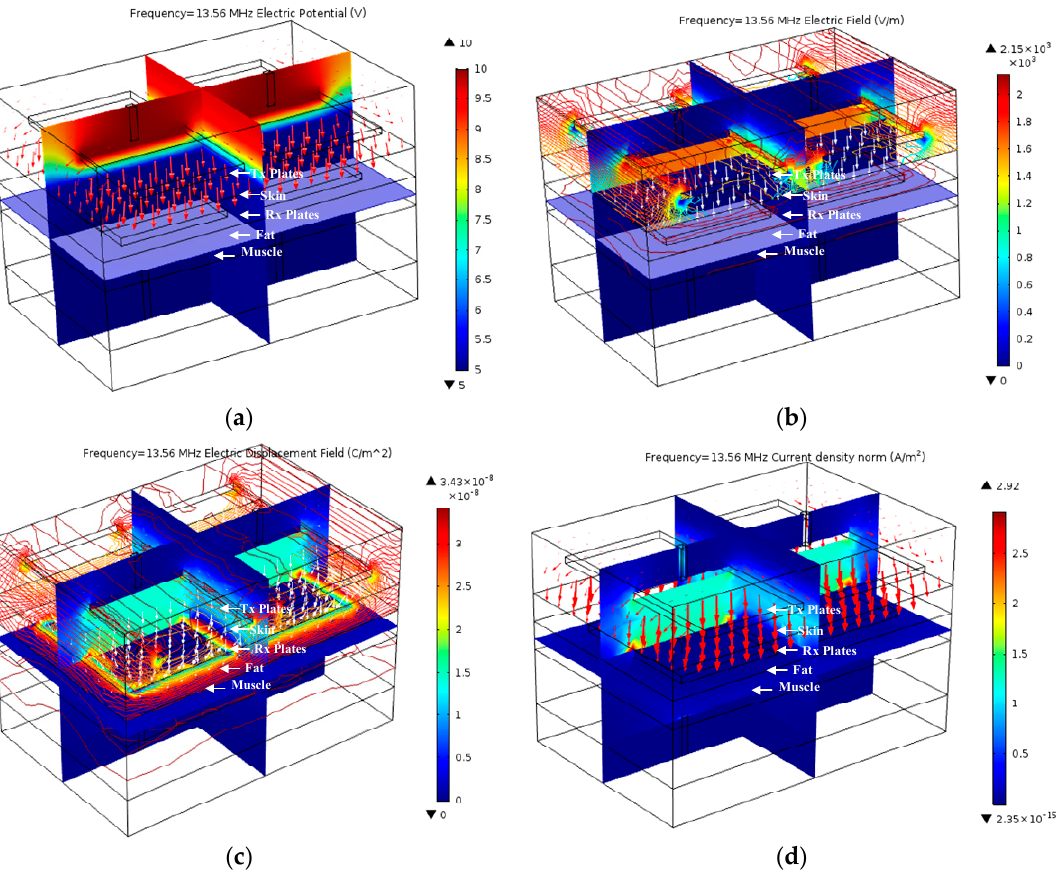
Figure 17. FEM simulation of CCWPT by placing Rx plates under the skin: ( a ) electric potential; ( b ) electric field normal; ( c ) electric displacement field; and ( d ) current density.